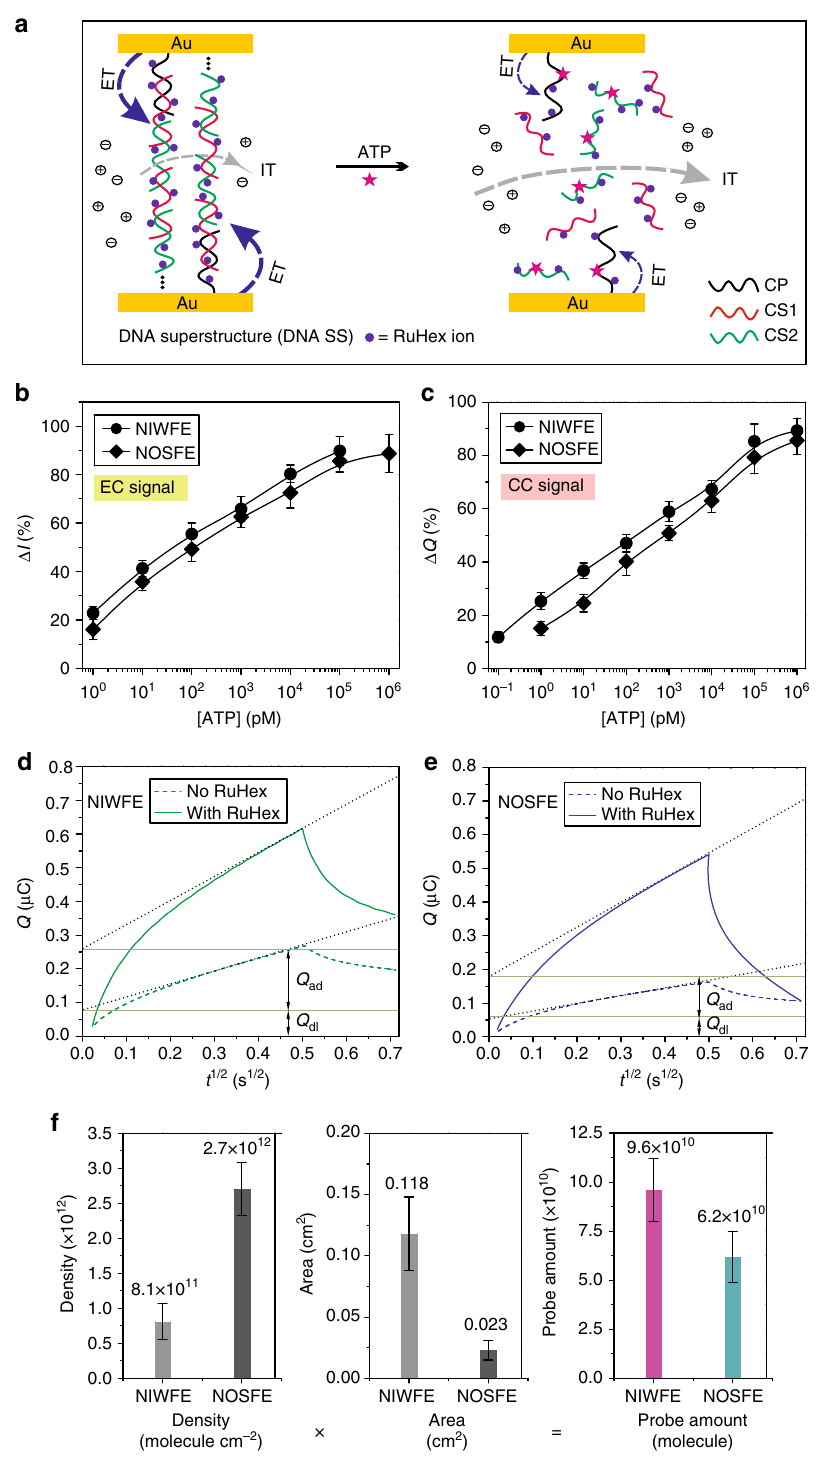
Fig. 5 Revealing ion-gating ef fi ciency through probes density calculation. a Schematic showing IT (dashed gray arrow) and ET (dashed blue arrow) through DNA SS – RuHex system. CP capture probe; CS1 complementary strand 1; and CS2 complementary strand 2 (also see Supplementary Fig. 2). b , c Dynamic response to ATP of regionally assembled DNA SS – RuHex system using differential pulse voltammetry (DPV, b ) and chronocoulometry (CC, c ) measurements. d , e Chronocoulometry response curves of thiolated CP + MCH monolayers with (solid line) and without (dashed line) RuHex ions adsorption at the inner wall ( d ) and outer surface ( e ) of nanochannels, respectively. Here, Q ad and Q dl represent the charge from electrochemical reduction of the adsorbed RuHex ions and the capacitive charge, respectively. f Comparison of DNA probe assembly density, regionally functional area, and probe molecule amount at different domains of the nanochannels. Error bars represent standard deviations of independent triple